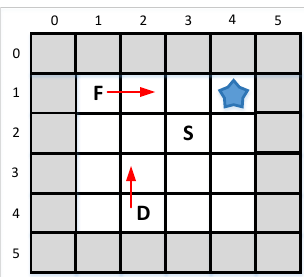
Figure 2. The farmer and the dog want to steer the sheep to the location marked by a star. The program captures the behavior of the farmer and the dog and the environment captures the behavior of the sheep. A good program uses the assistance of the sheep (i.e., the environment) while overcomes its disruption to steer it to the desired